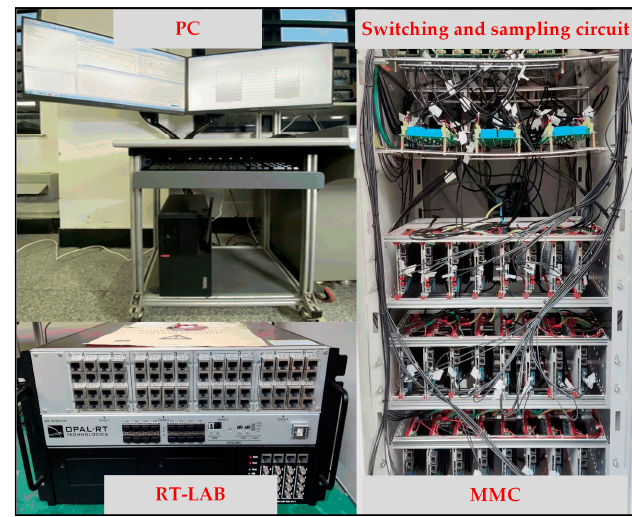
Figure 13. The prototype of the Opal-RT ® OP5700 driven MMC. Table 3. The simulation and experimental parameters.